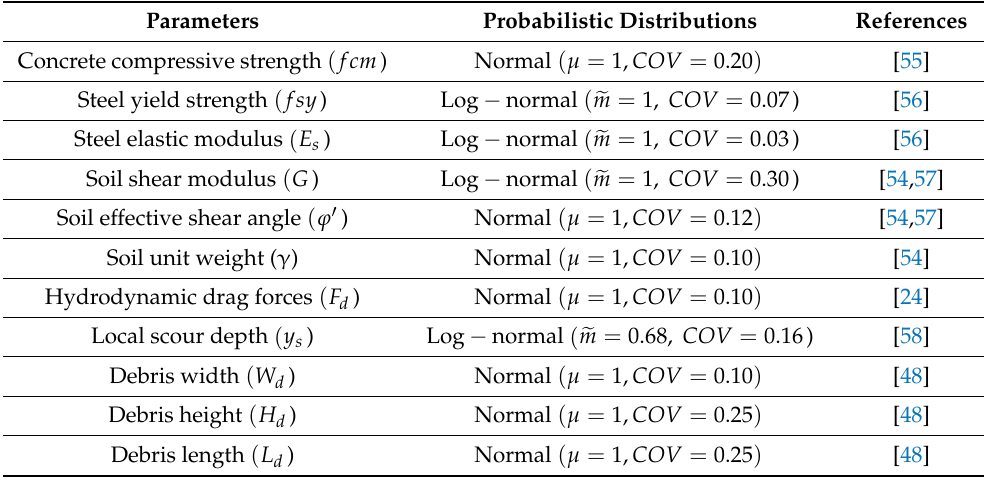
Table 3. Random variables used in the flood vulnerability analysis.